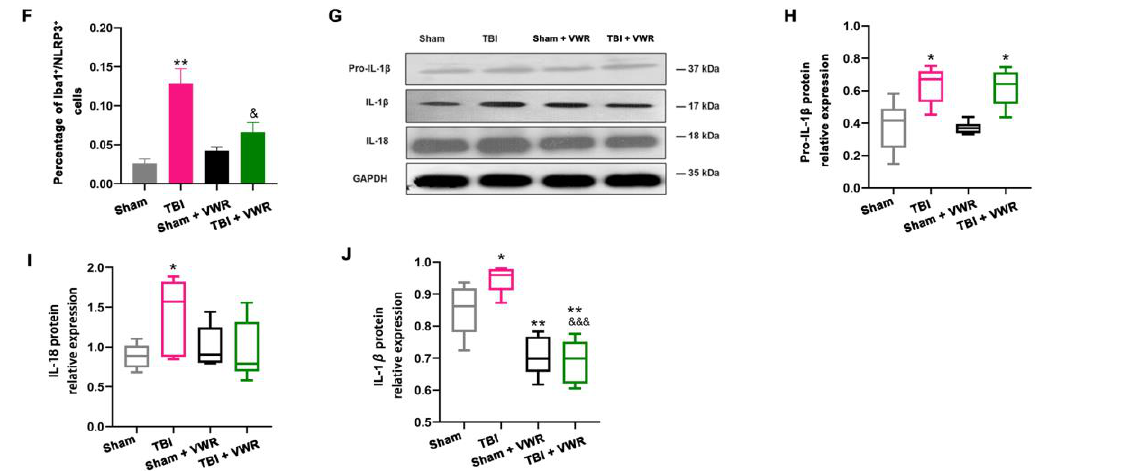
Figure 4. VWR reduced the activation of NLRP3 signaling. ( A ) TBI-induced elevation of NLRP3 mRNA in the perilesional cortex significantly decreased after VWR. ( B – D ) TBI-induced increase of pro-caspase-1 and caspase-1 proteins in the perilesional cortex significantly decreased after VWR. ( E , F ) Consistently, the increased expression of NLRP3 (green in E ) in activated microglia (red in E ) significantly decreased after VWR. ( G , H ) The protein level of pro-IL-1 β increased significantly after TBI. However, it did not affect by VWR. ( G , J ) The protein level of mature IL-1 β increased significantly after TBI and remarkably dropped after VWR. The VWR-induced reduction was independent of injury. ( G , I ) The protein level of IL-18 was similar to NLRP3 and significantly increased after TBI. ** p < 0.01, * p < 0.05 vs. Sham, &&& p < 0.0001, && p < 0.01, & p < 0.05 vs. TBI. One-way ANOVA, Post hoc Sidak’s multiple comparisons tests; n =5. Iba1: red; NLRP3: green; DAPI: blue; scale bar = 100 µ m. VWR, voluntary wheel running; NLRP3, NOD-like receptor thermal protein domain associated protein 3; TBI, traumatic brain injury; Iba1, Ionized calcium-binding adaptor molecule 1; IL-1 β , interleukin 1 β ; IL-18, interleukin 18.